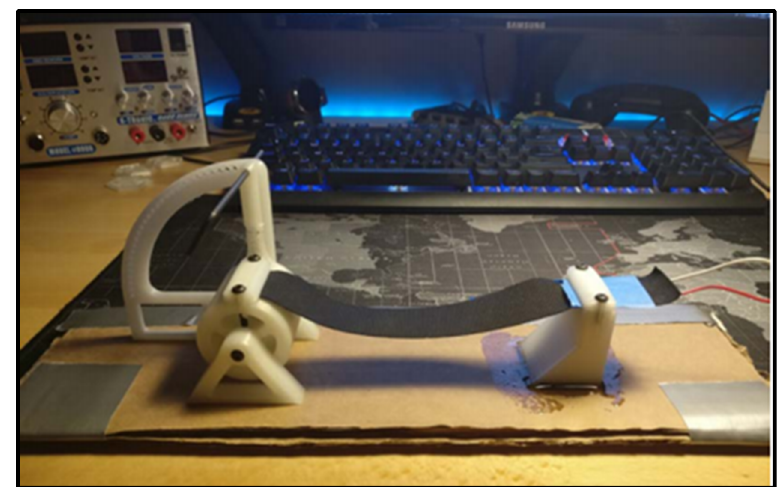
Figure 5. Wrist motion test apparatus (Iteration II).